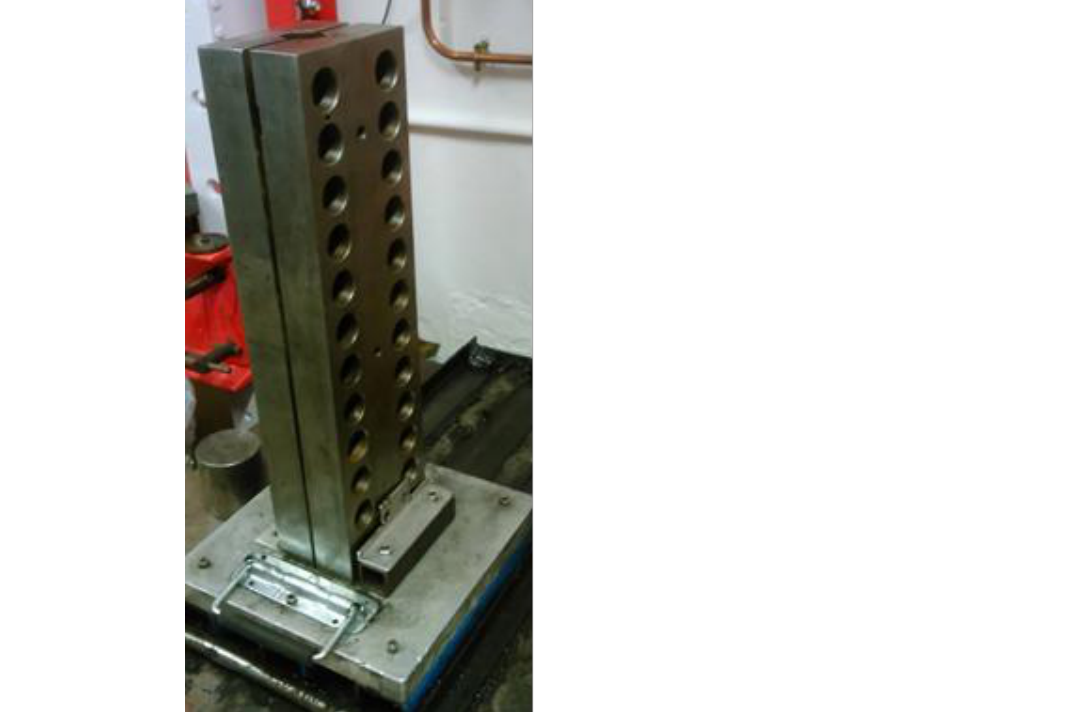
Figure 6. Hexagonal split mold.